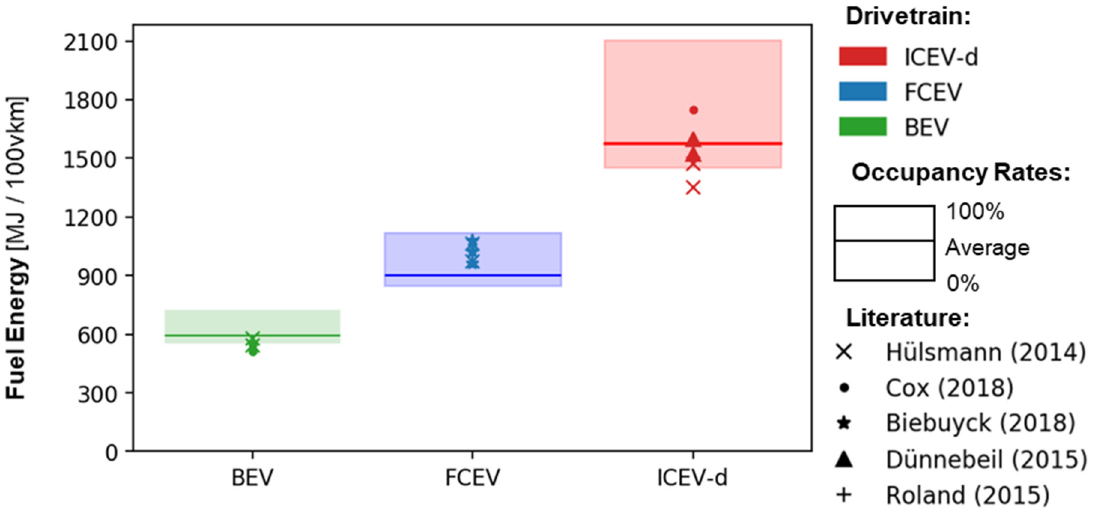
Figure 5. Model vs. literature energy demand for medium buses [59,60]. The solid lines represent the fuel energy demand for the average occupancy rate. The shaded area represents the energy demand for varying occupancy rates of between 0% and 100%, according to the model.